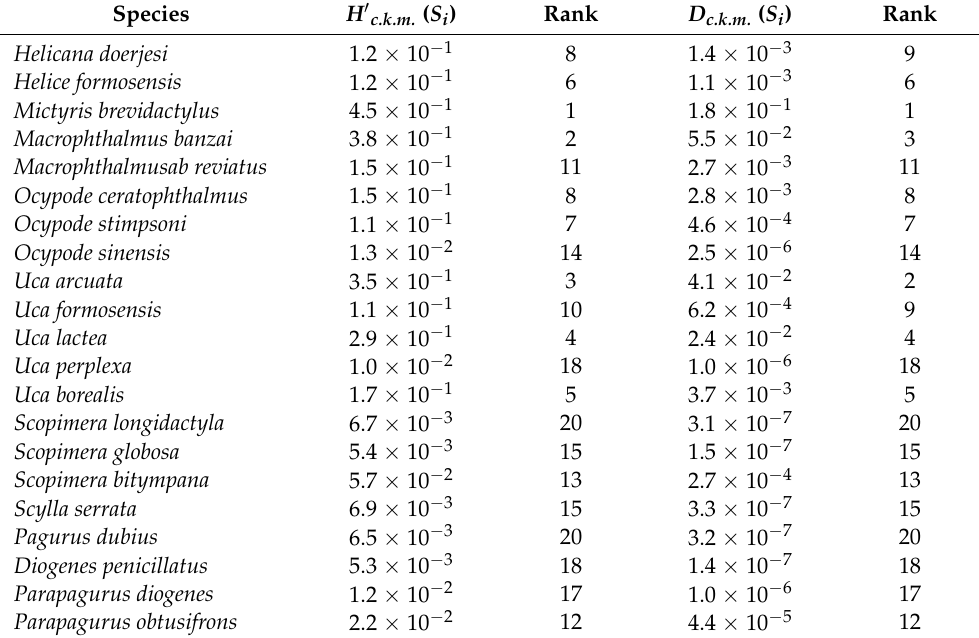
Table 1. Probabilities of contribution to biodiversity ( H (cid:48) c.k.m. and D c.k.m. ) and each rank by crab species ( S i ). Species H (cid:48) c.k.m. ( S i )